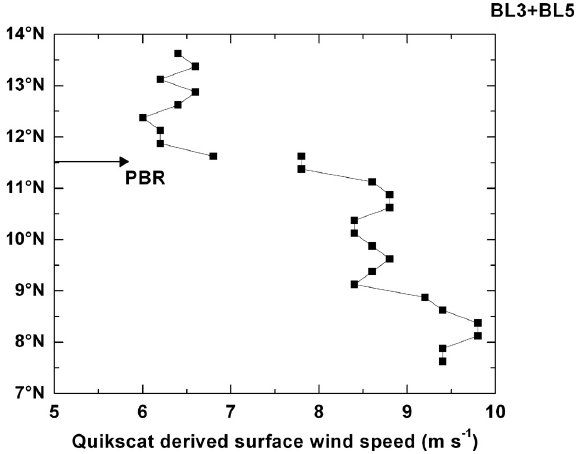
Fig. 15. Longitudinal variation of wavelength exponent ( α) off- VSK (BL1, top panel) and off-CHN (BL6, bottom panel) at 770m and 1550m altitudes. Solid line and dashed lines indicates 5 point running mean at 770m and 1550m altitudes,